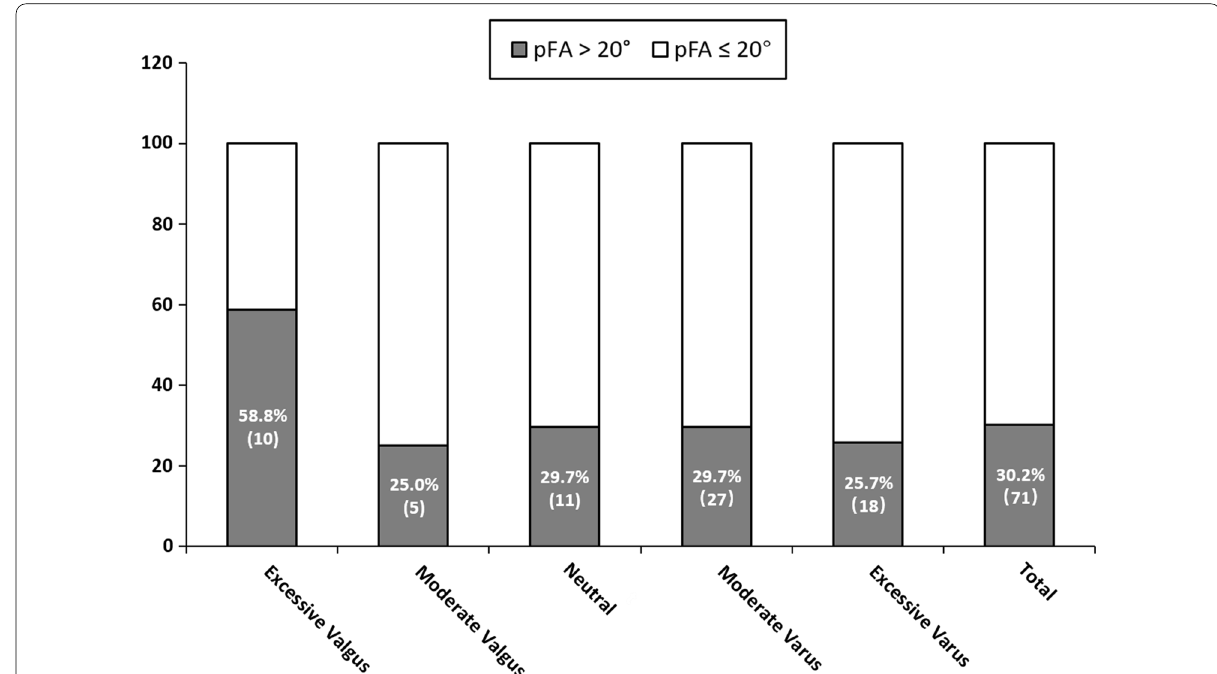
Fig. 4 Numbers and ratios of the patients with pFA